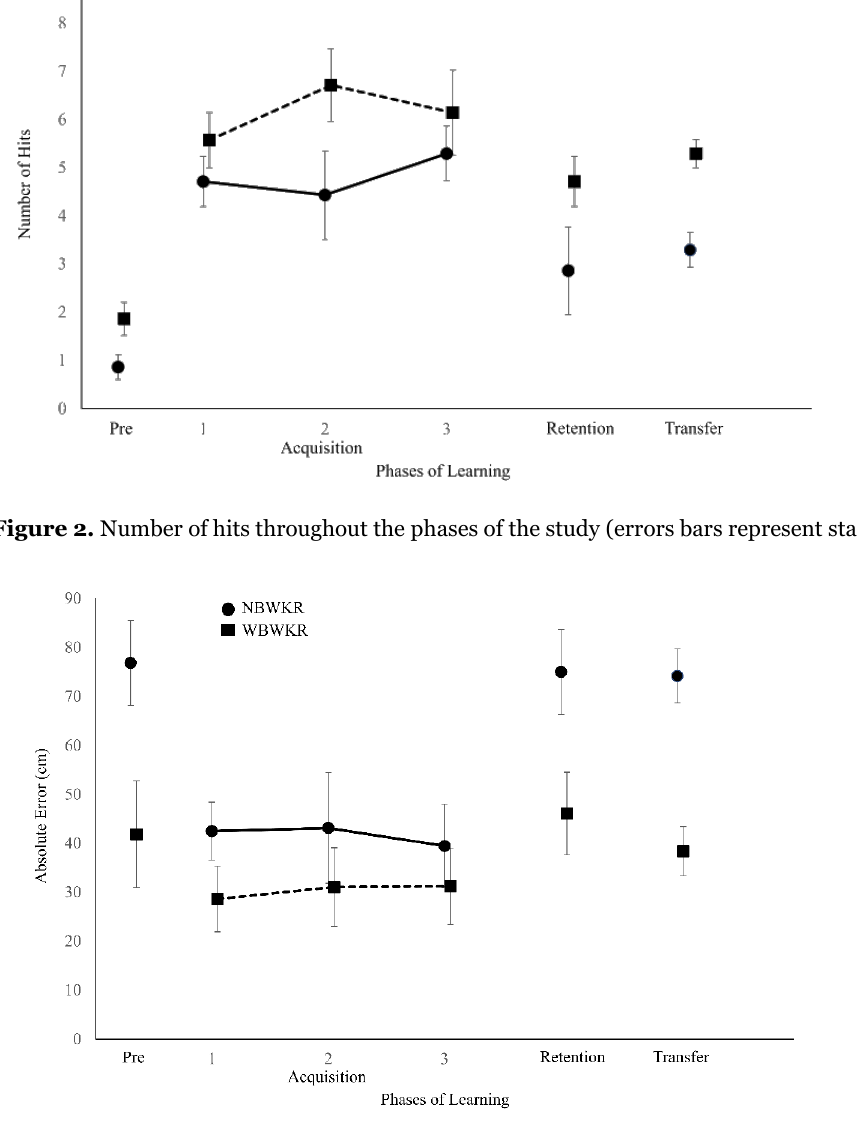
Figure 3. Absolute error throughout the phases of the study (errors bars represent standard